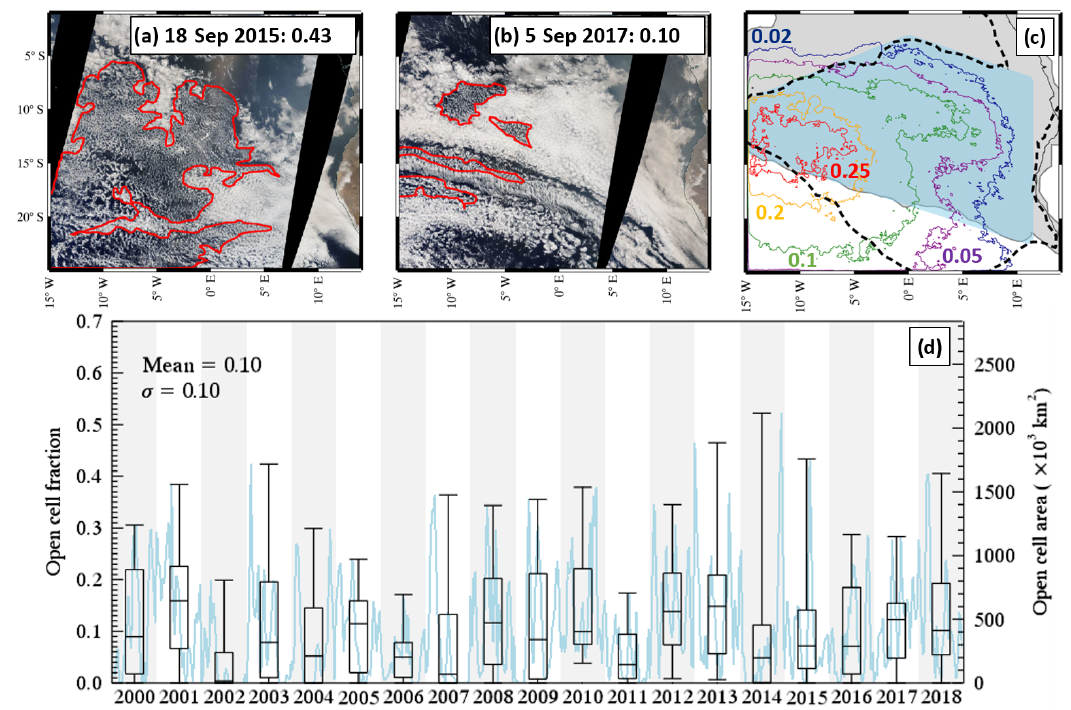
Figure 15. Evaluation of the open cell fraction from 19 years of MODIS Terra imagery. Panels (a, b) are illustrative examples that show the manual identification of open cell features in red. The MODIS imagery was obtained from NASA Worldview. Panel (c) shows a spatial map of the September 2000–2018 mean open cell fraction (0.02, 0.05, 0.1, 0.2 and 0.25 contours). The grey shaded region represents the area where the MODIS Terra level 3 product’s September 2000–2018 mean fine-mode aerosol optical depth exceeds 0.2, and the black dashed line indicates the 0.6 total liquid cloud fraction contour. We approximate the area where both the fine-mode AOD is > 0.2 and the cloud fraction is > 0.6 with the light blue shaded region. The blue line in panel (d) shows the daily open cell fraction and the corresponding open cell area calculated in this blue shaded region for September 2000–2018. The box and whiskers summarise the individual monthly data. The open cell fraction for the example cases in panels (a, b) in the blue shaded region is 0.43 and